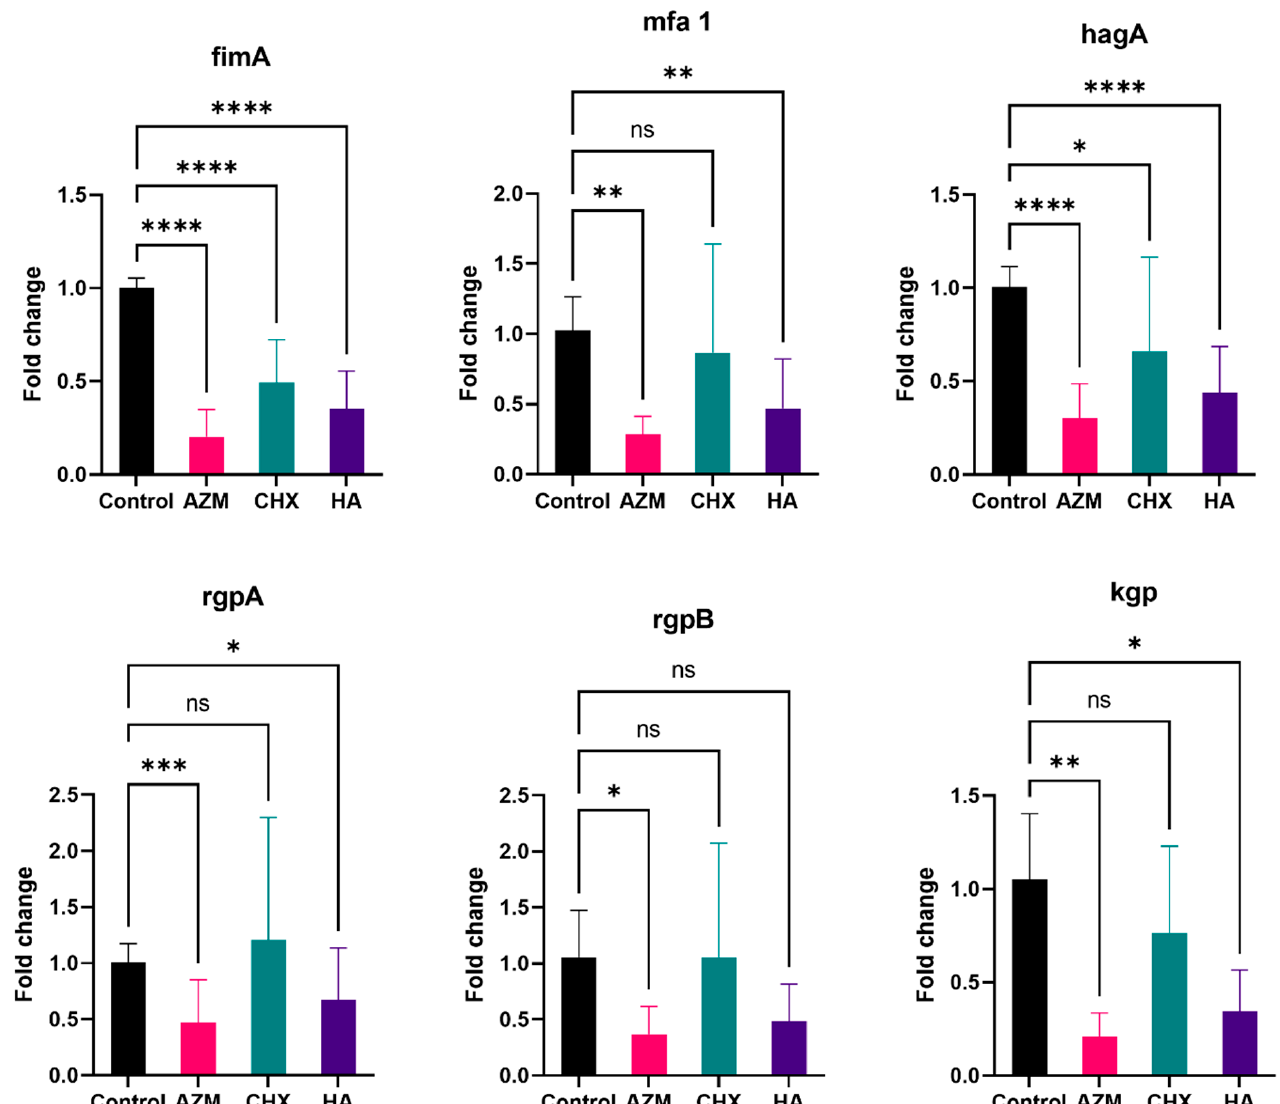
Figure 3. Overall fold-change values (mean ± SD) for independent genes. >0.05 (ns), ≤ 0.05 (*), ≤ 0.01 (**), ≤ 0.001 (***), ≤ 0.0001 (****).